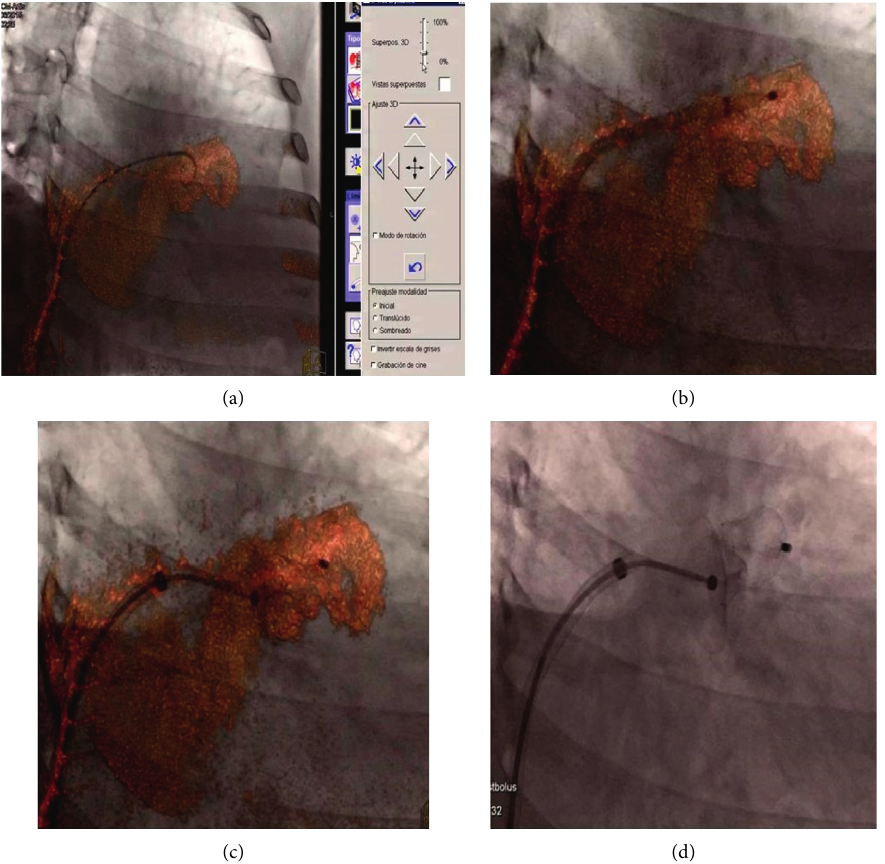
Figure 1: LAAC guided by rotational angiography. (a) Syngo i-Pilot ® (Siemens, Germany) software allows the generation of the left atrial appendage mask by tomographic rotational acquisition during intraappendage angiography. Appendage mask is superimposed to fluoroscopic images, changing its shape as the projection changes. (b) Appendage cannulation with Amplatzer sheath and initiation of Amulet device deployment. (c) and (d) Final Amulet deployment with (c) and without (d) superimposed mask on